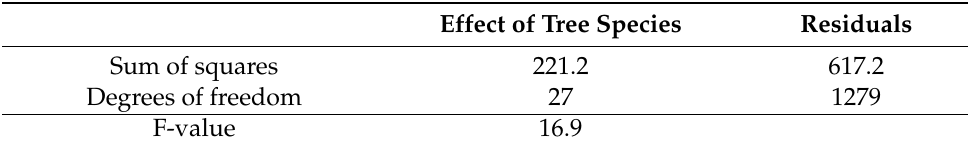
Table 5. Analysis of variance for the height increment of different tree species in the reforestation experiment, Wechsel, between 2017 and 2020.